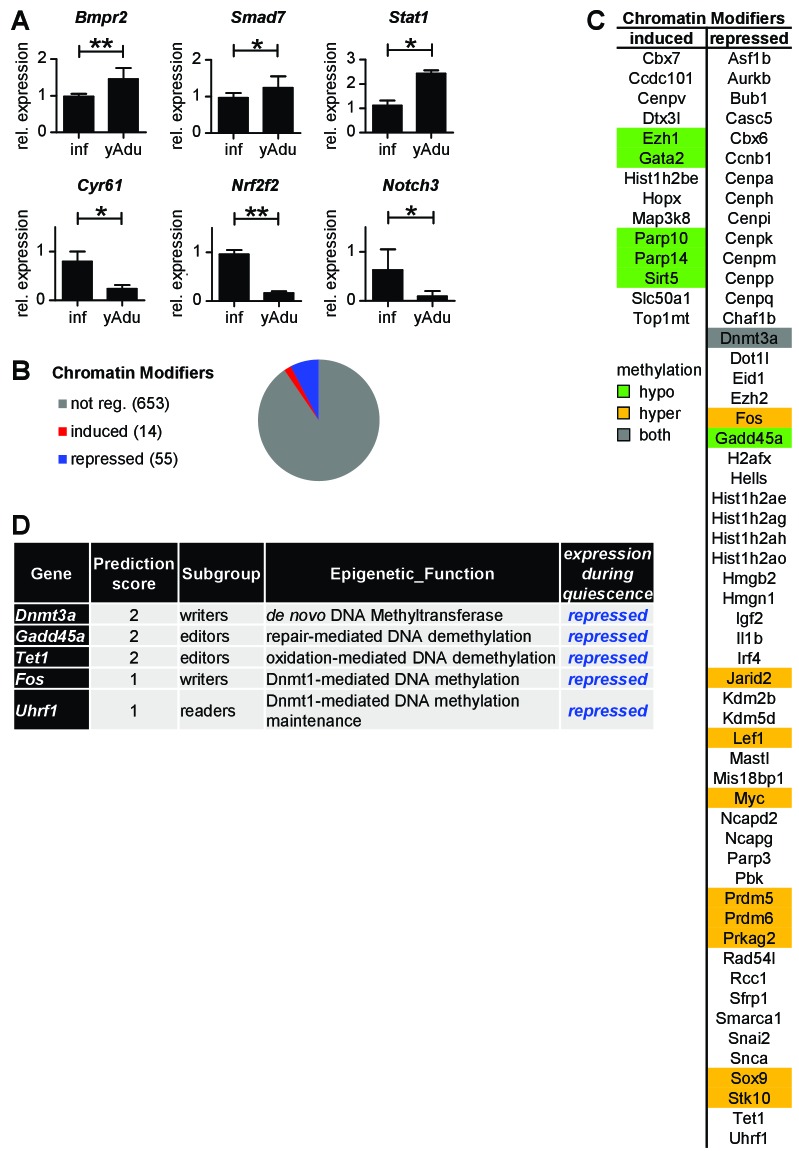
Analysis of vascular quiescence-dependent gene expression.(A) Validation of the expression pattern of anti- and pro-angiogenic molecules in lung EC by qPCR in independent biological samples. n ≥ 3; mean ±SD; *p<0.05; Mann-Whitney Test. (B) Quiescence-dependent expression analysis of chromatin modifying enzymes. (C) Differentially expressed chromatin modifiers as identified by RNA-seq analysis. (D) Quiescence-dependent expression analysis of chromatin modifying enzymes with focus on DNA methylation modifiers.